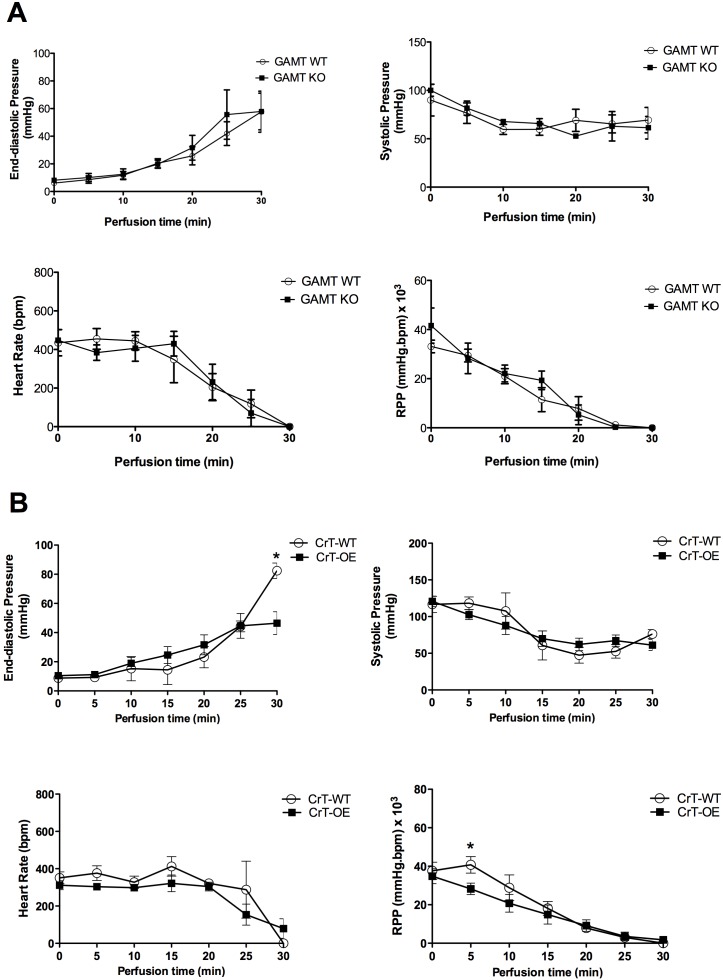
Effect of 0.5 µM H2O2 on cardiac function during 30 min exposure in isolated perfused GAMT KO hearts and wild-type (WT) controls (A).GAMT KO (n = 4) with the age and sex matched corresponding wild-type (GAMT WT) mice (n = 4; female). (B) Effect of 0.5 µM H2O2 on cardiac function during 30 min exposure in isolated perfused Cr-T overexpressing (CrT-OE) hearts (n = 7; 7 female) and age matched wild-type (CrT-WT) controls (n = 4; female). RPP- rate pressure product. *P<0.05 vs WT. Data mean±S.E.M. P value is for the effect of the genotype by ANOVA with Bonferroni’s correction.